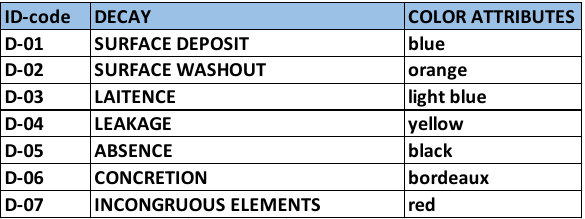
Figure 13. ID-code attributing to the material decay (legend of the Figure 14)